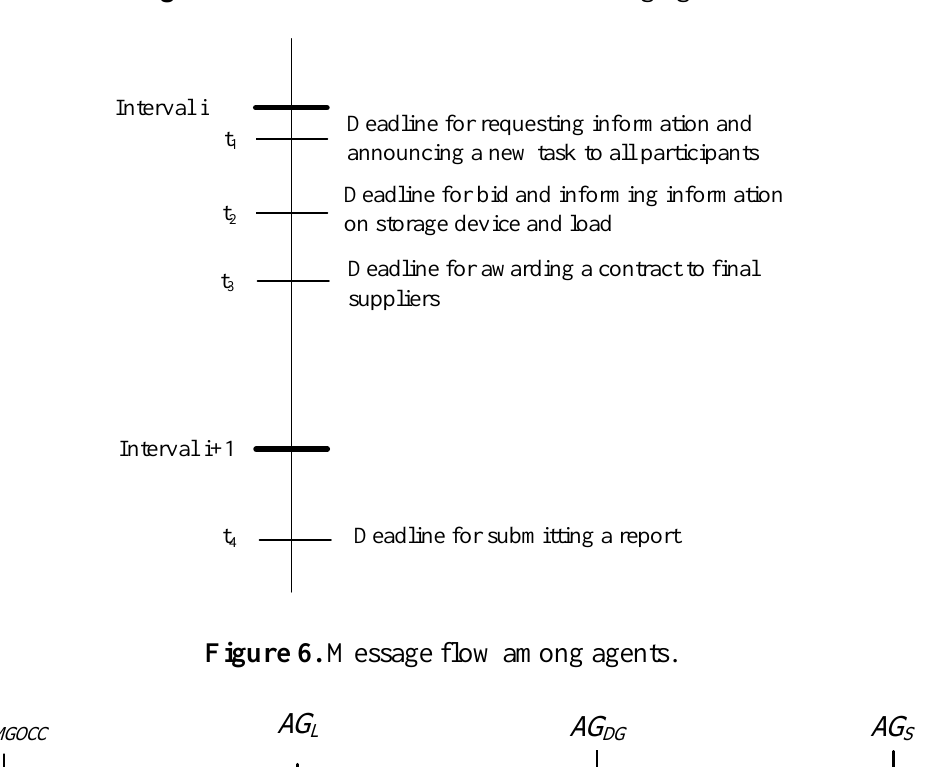
Figure 5. Deadlines for interactions among agents.